Question: Write a descriptive caption for this figure.
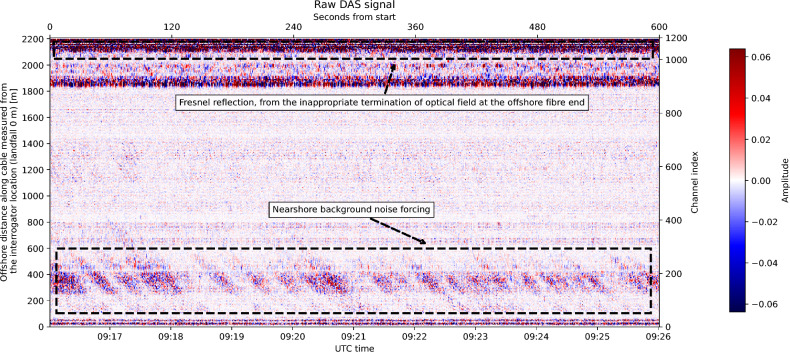
Answer: Raw DAS phase-rate data over a 600 s window. phase-rate amplitudes recorded along the 2 km EMEC Eday cable (1 kHz sampling, 2.04 m spacing, 10 m gauge length) are shown as a function of time.